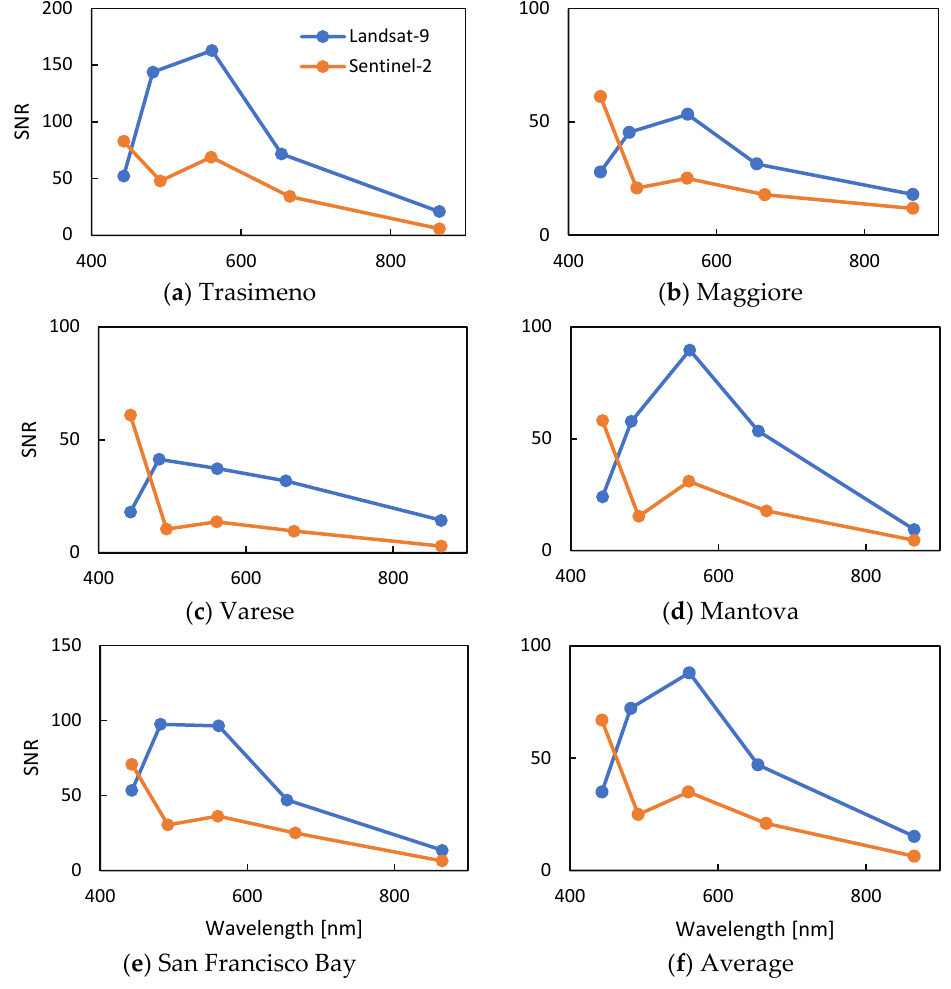
Figure 16. Image-based SNR estimates of Landsat-9 and Sentinel-2 for each case study. Because sensor noise determines the thresholds for the absolute and relative concen- trations of water constituents, concentration maps show a characteristic salt and pepper pattern close to these thresholds. Such a pattern is obvious in all Chl-a maps from lake Trasimeno (Figure 9) and the TSM map from 24 January 2022 (Figure 8) from Sentinel-2, while the Landsat-9 maps appear noise-free. This demonstrates that Landsat-9 has lower detection limits than Sentinel-2, particularly for Chl-a.